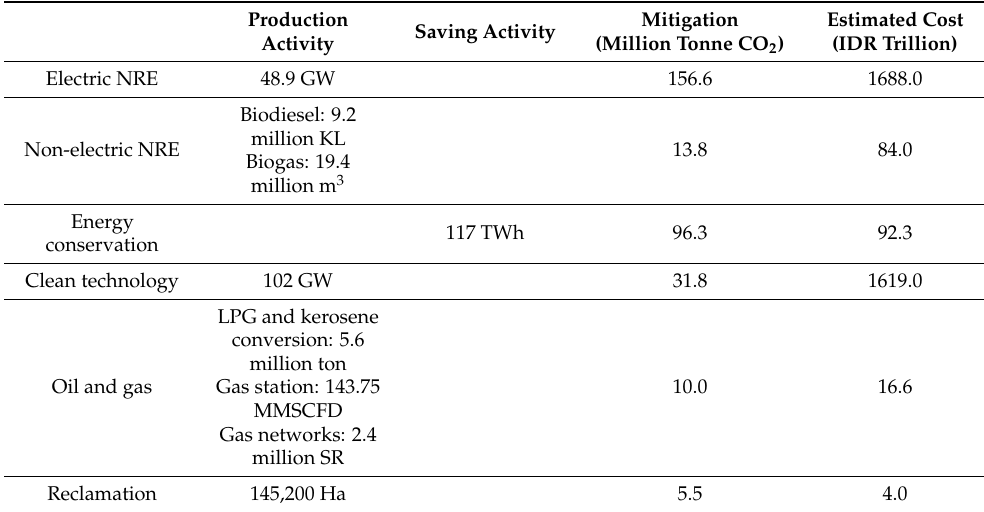
Table A2. Costs and benefits of Indonesia’s energy transition [75].